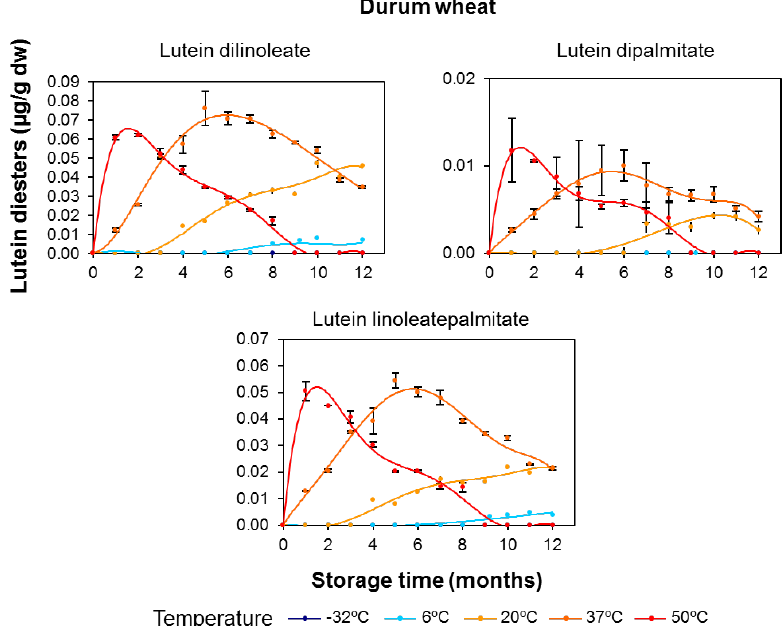
Figure 6. Evolution of the diesterified lutein (μg/g dry weight) in durum wheat (Don Pedro variety) whole-grain flours during long-term storage under temperature controlled conditions (−32, 6, 20, 37 and 50 °C). The values shown are the mean and standard error ( n = 5 for the starting sample, n = 3 for the rest of the samples).